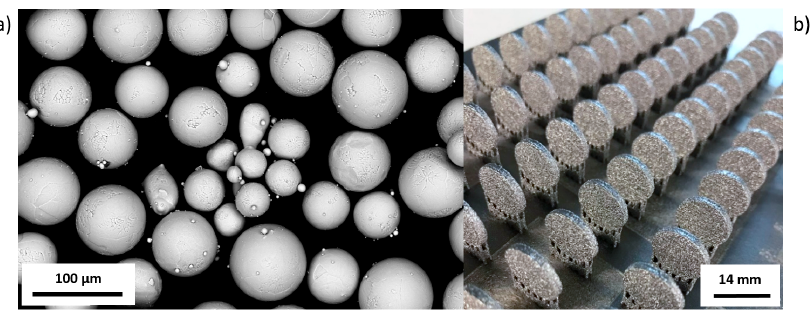
Figure 1. ( a ) SEM image of Ti6Al4V ELI (Arcam AB) powder particles. ( b ) View on the platform with